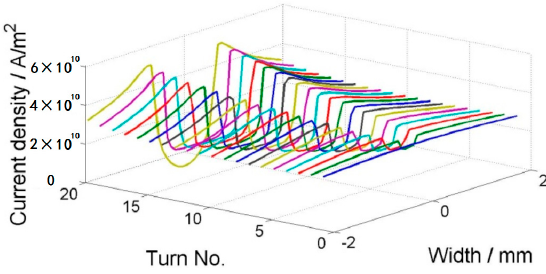
Figure 10. The current distribution when the applied current is 101 A and the external field is in-phase 0.2 T; the inner turn of the SuNAM 20-turn coil is fully penetrated.